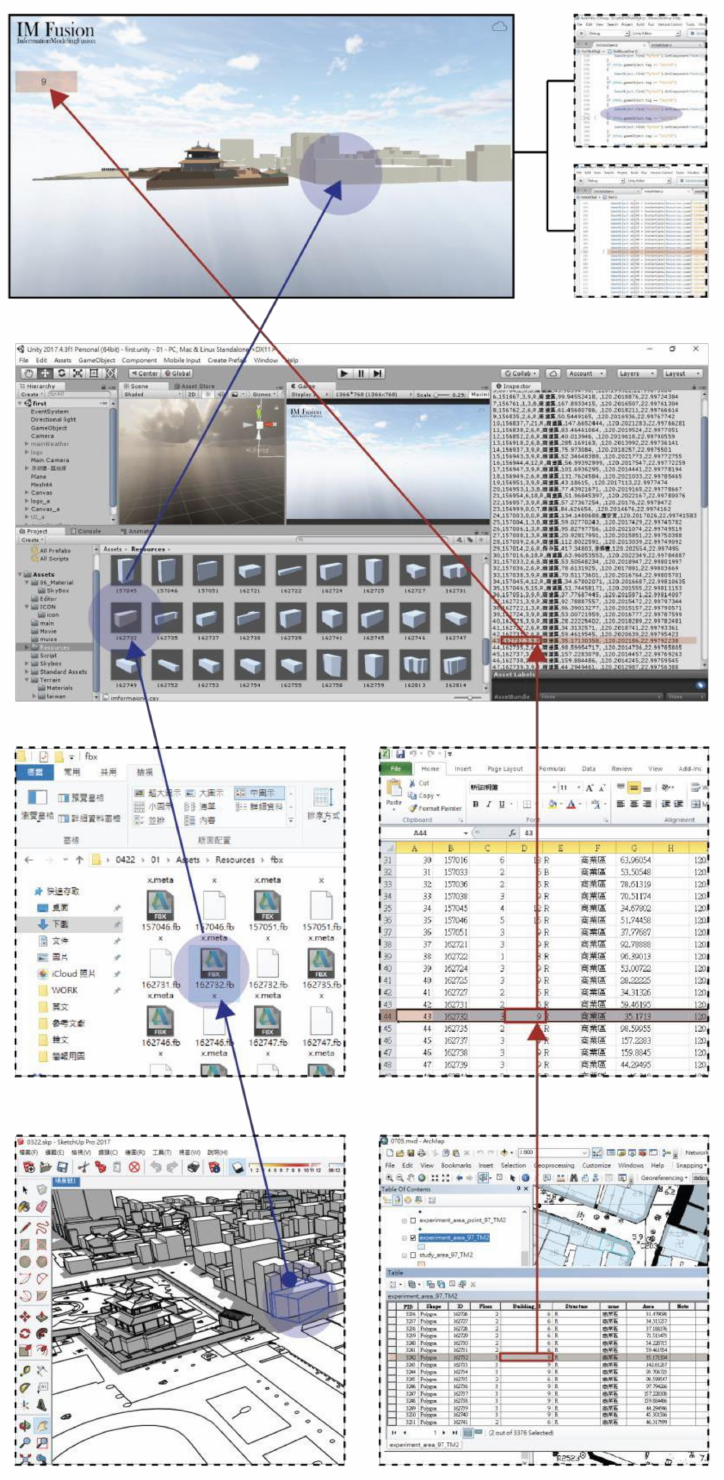
Figure 12. Flow chart of integrating volume building and attribute data by C# interactive program script.